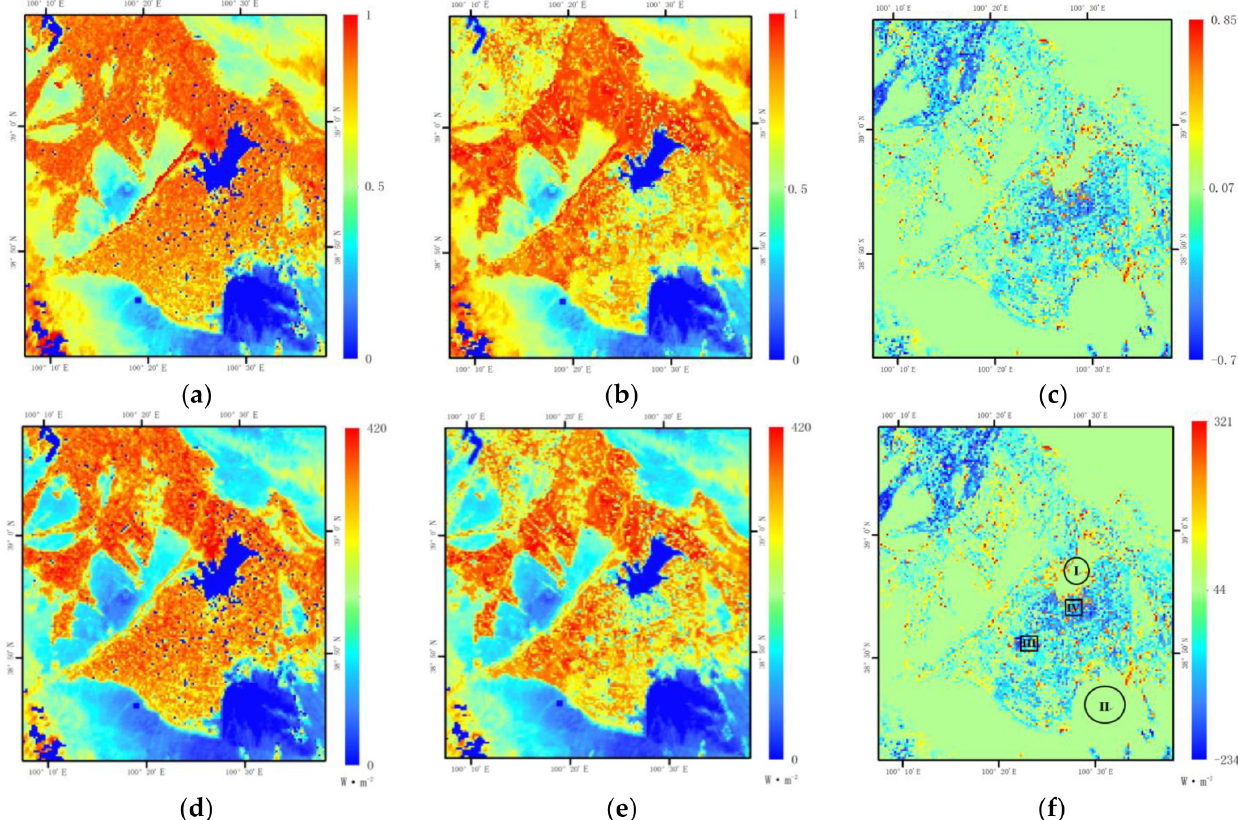
Figure 5. Maps of (a) lumped EF, (b) EFAF EF, (c) difference between EFAF and lumped EF (EFAF EF minus lumped EF), (d) lumped daily LE, (e) EFAF daily LE, and (f) difference between EFAF and lumped LE (EFAF LE minus lumped LE) on 8 July